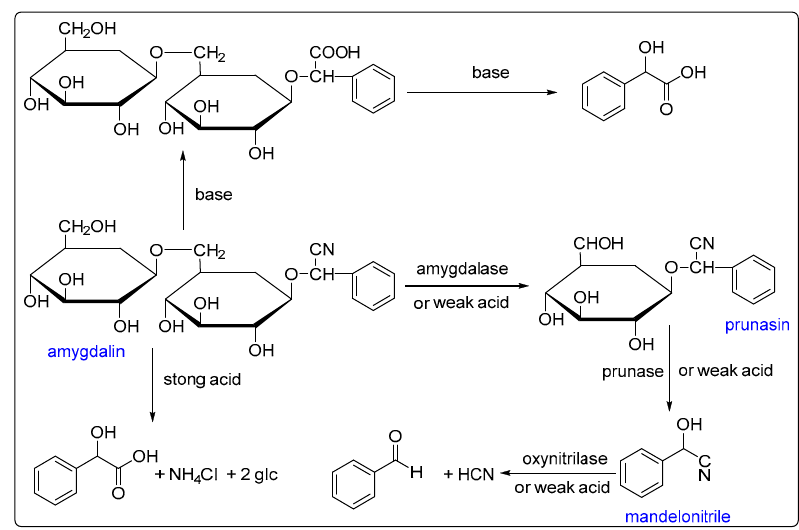
Figure 1. Hydrolysis of amygdalin.